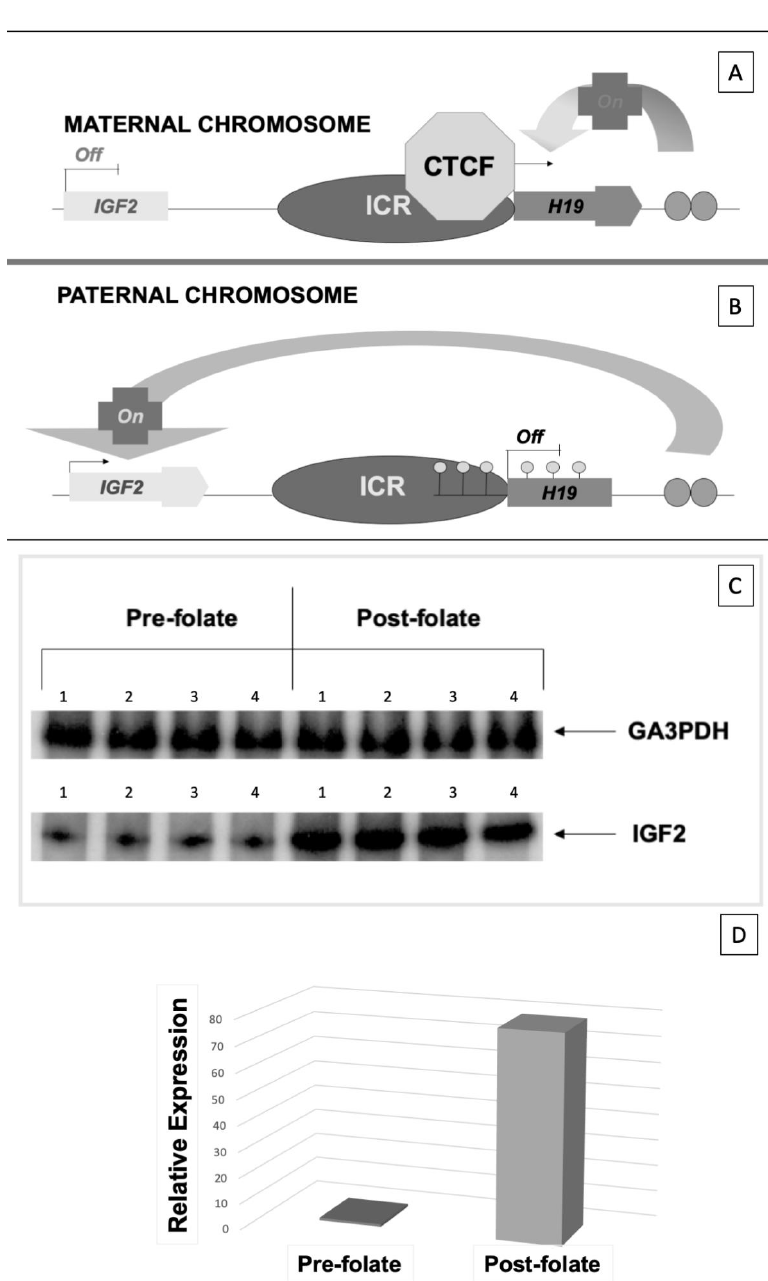
Figure3. Effectofafolatetreatmentontheexpressionoftheimprintedgene IGF2 ,inhyperhomocysteinemic Figure 3. Effect of a folate treatment on the expression of the imprinted gene IGF2 , in uremic patients. ( A , B ); schematic representation of the inverse regulatory mechanisms for the selective hyperhomocysteinemic uremic patients. ( A) and ( B) ; schematic representation of the inverse monoallelic expression of H19 and IGF2 from the paternal chromosomes. The two genes are under regulatory mechanisms for the selective monoallelic expression of H19 and IGF2 from the paternal the control of the same imprinting control region (ICR). Differential methylation is responsible for the differential expression of each imprinted gene according to parent-of-origin effects. On the maternal chromosome, absence of ICR methylation induces insulation of IGF2 , through the interaction of the ICR with the trans factor CTCF, and allows monoallelic expression of H19 ( A ). Methylation of the paternal ICR, ensures silencing of H19 , allowing the permissive activity of a downstream enhancer on the IGF2 promoter ( B ). Panel C–D; four CKD patients in end-stage renal disease, treated with renal replacement therapy (hemodialysis), were subject to folate wash out (prefolate), then a standard folate treatment (methyltetrahydrofolate) was administered (post-folate). Pre-folate and post-folate levels of expression of IGF2 mRNA were measured before and after folate treatment in four CKD- end-stage renal disease (ESRD) patients. ( C ): semiquantitative analysis of labeled PCR products; ( D ): real time PCR; for details see